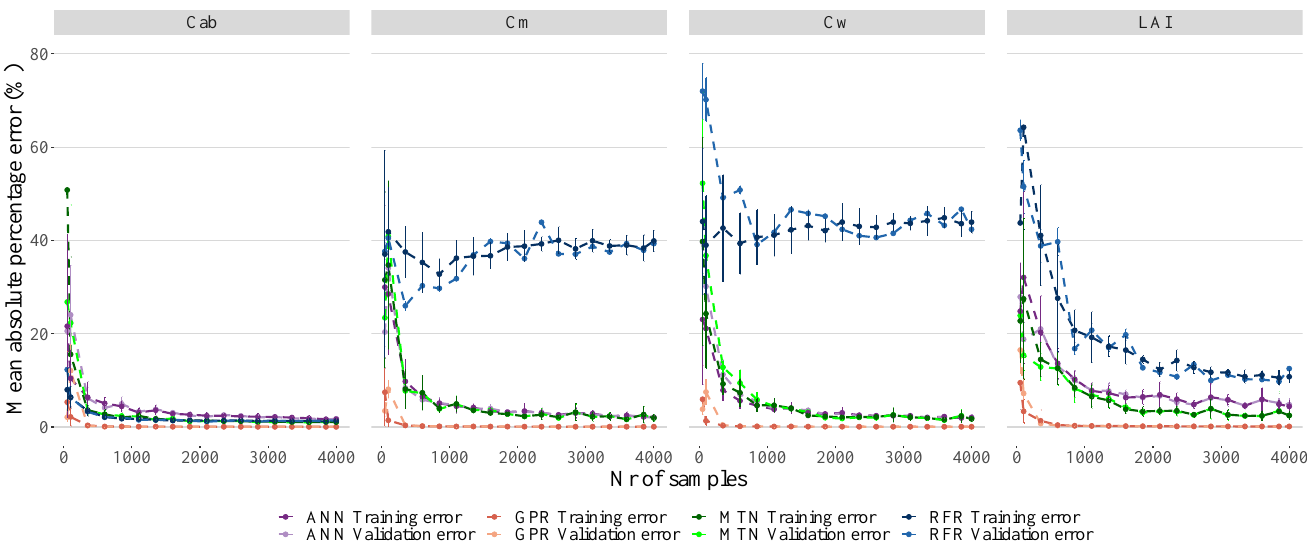
Figure 6. Model performance on pure PROSAIL RTM simulation. While each model has its own color, the darker colors represent the training error. The data used for these plots is accessible in the Github repository provided at the end of this manuscript.